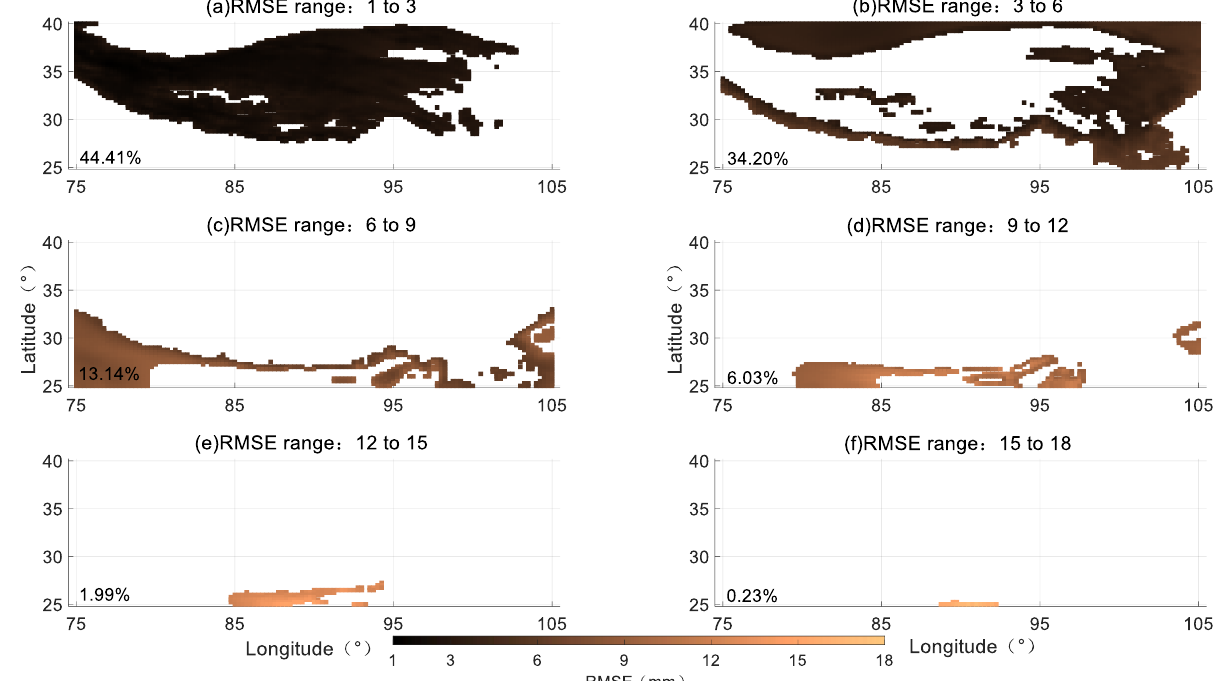
Figure 11. The RMSE distribution of ASV-PWV.